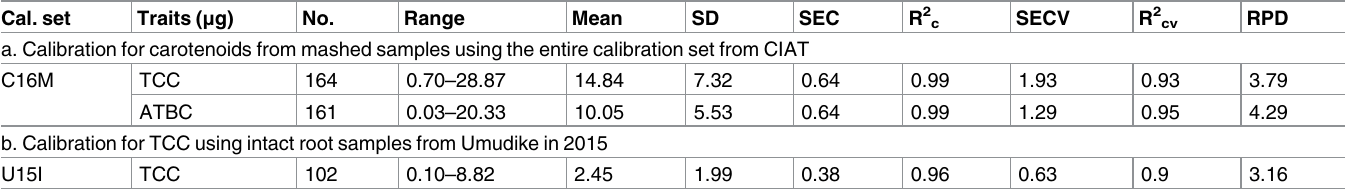
Table 5. Calibration assessments of carotenoids from mashed (a.) and intact (b.) root samples. Cal. set